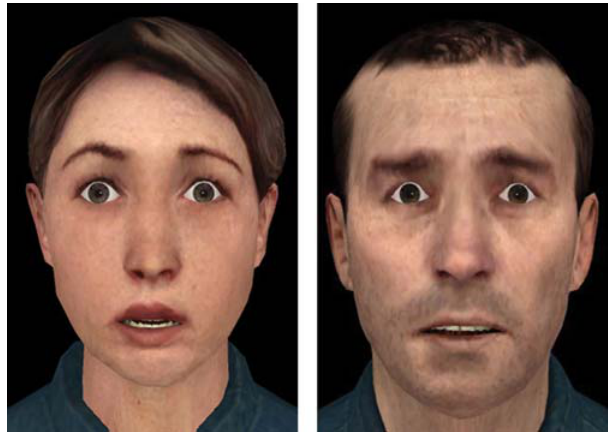
Figure 4. Examples of virtual emotion: fear expression in one male and one female